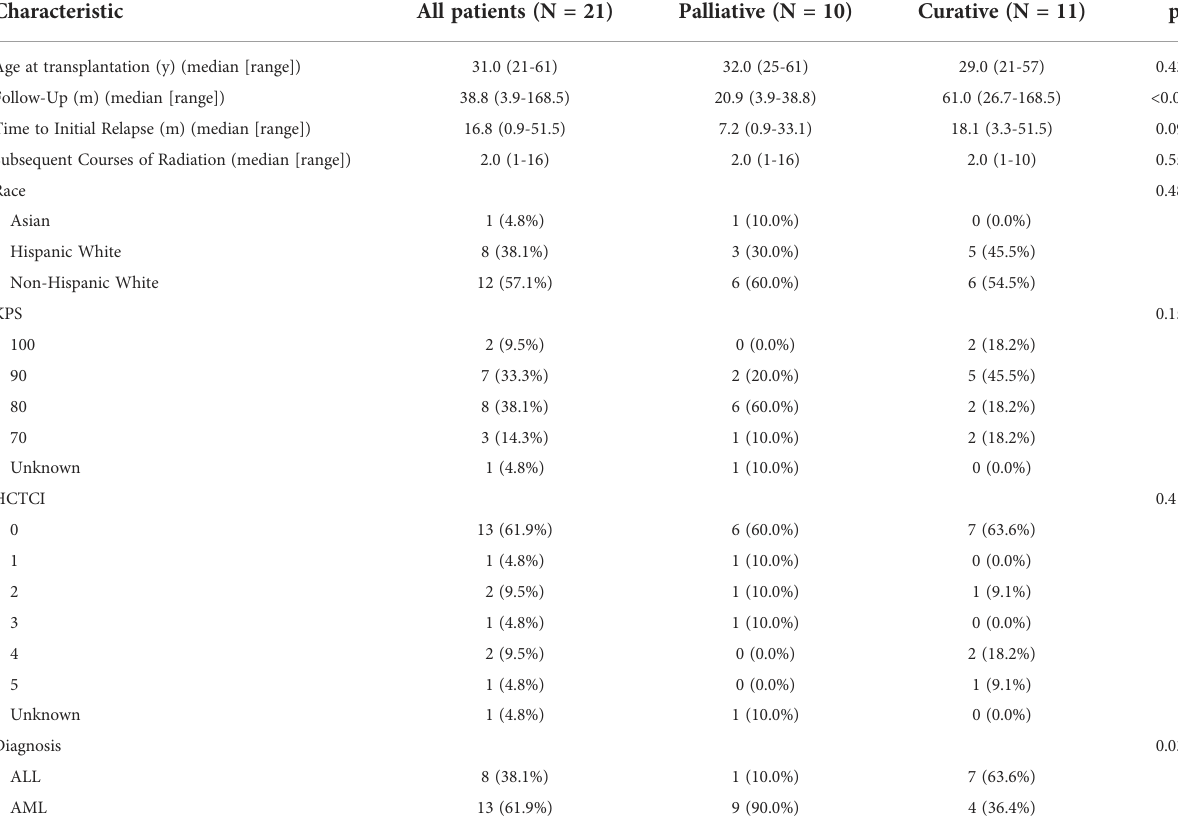
TABLE 1 Patient